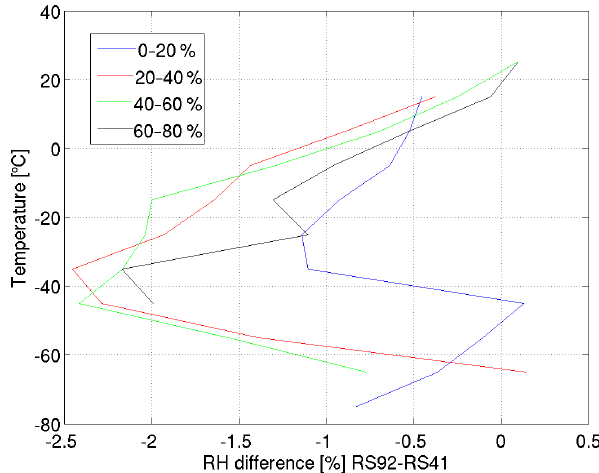
Figure 17. Median difference in relative humidity between the RS92 and RS41 radiosondes as a function of temperature for four different relative humidity ranges.